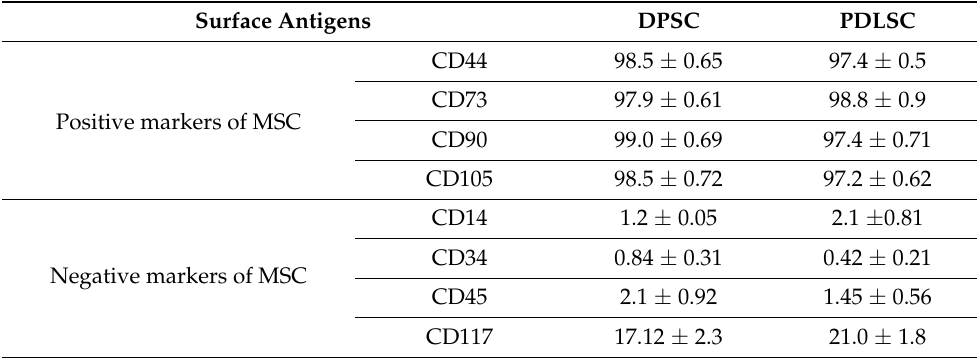
Table 2. The number of cells expressing positive and negative surface markers of MSC in cell cultures (passage 2) obtained from the dental pulp of permanent teeth (DPSC) and the periodontal ligament (PDLSC).